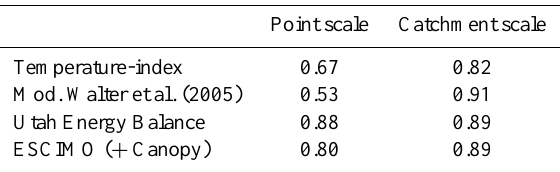
Table 4. Nash–Sutcliffe model efficiencies E at the point and the catchment scale, respectively. Statistics refer to the winter season 2010–2011 (validation